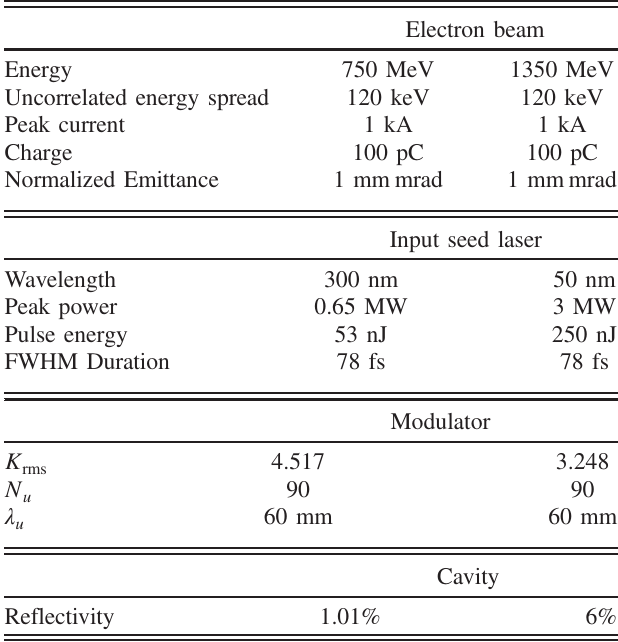
TABLE I. Parameters used for simulations. The rms undulator parameter is referred to as K , the number of undulator periods rms as N u , and the undulator period as λ u